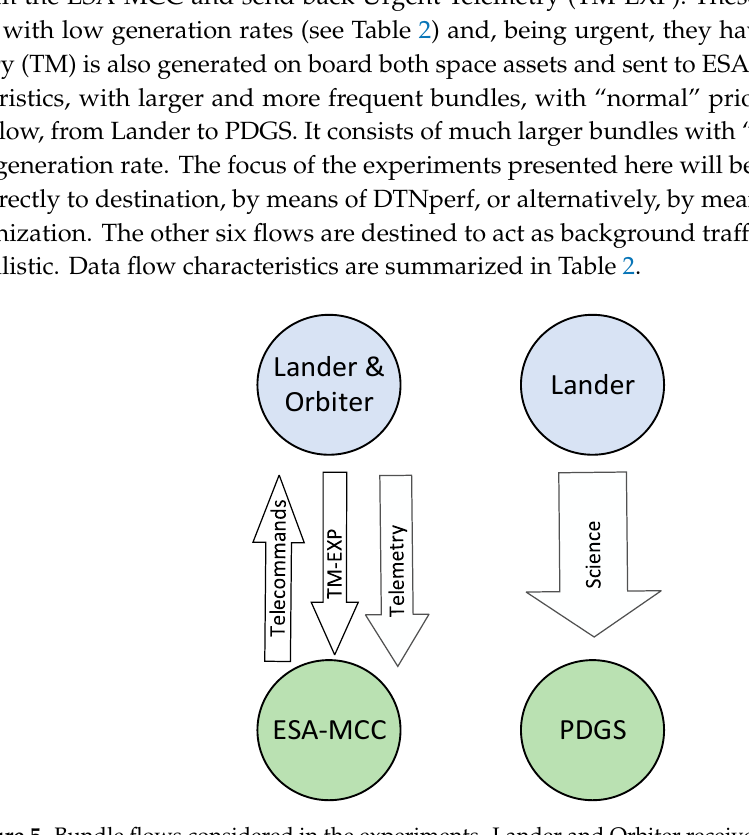
Figure 5. Bundle flows considered in the experiments. Lander and Orbiter receive Telecommands from ESA-MCC and send both Urgent Telemetry (expedited priority) and Telemetry (normal priority) to it. The Science flow (bulk priority) is sent from Lander to PDGS.